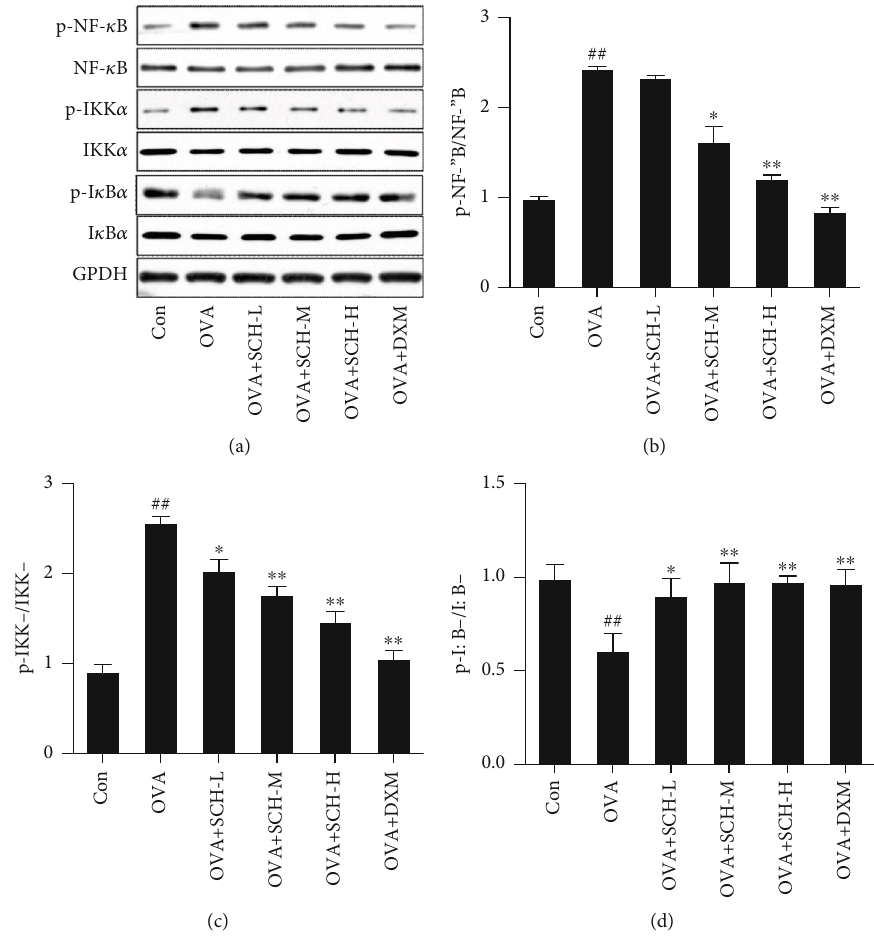
Figure 7: E ff ect of SCH on NF- κ B pathways. (a) The levels of p-NF- κ B, NF- κ B, p-IKK α , IKK α , p-I κ B α , and I κ B α were analyzed using Western blotting. (b – d) Quanti fi cation of the relative density of p-NF- κ B/NF- κ B, p-IKK α /IKK α , and p-I κ B α /I κ B α . Data are reported as the means ± SD ; n = 4 . ## p < 0 : 01 compared with the control group; ∗∗ p < 0 : 01 and ∗ p < 0 : 05 compared with the OVA